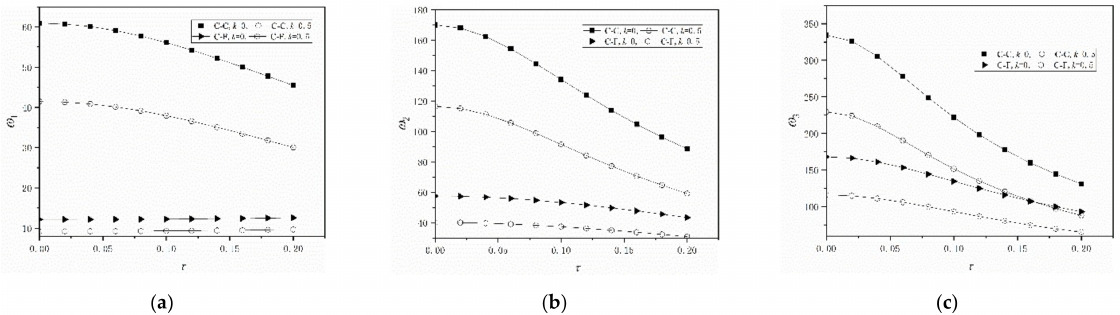
Figure 6. The relationship between dimensionless natural frequencies and the nonlocal parameter under two different boundary conditions (Mindlin plate). ( a ) The first-order frequencies; ( b ) The second-order frequencies; ( c ) The third-order